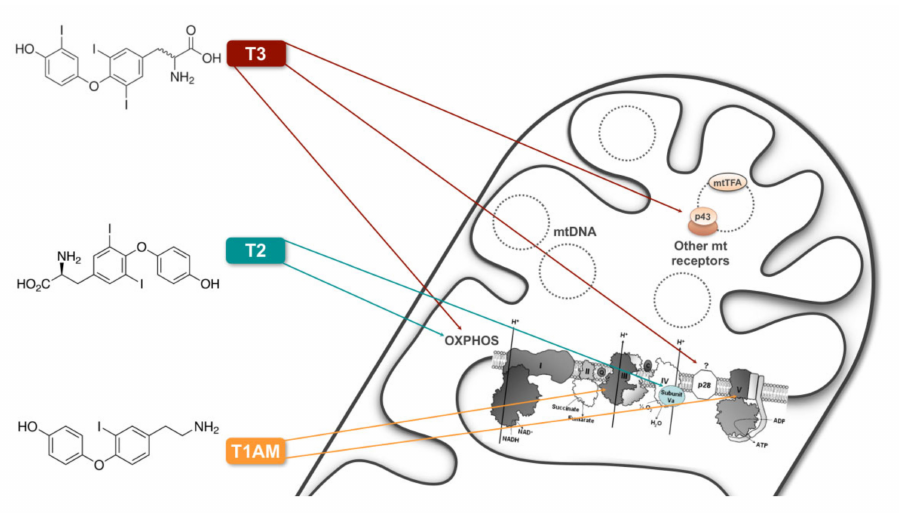
Figure 2. Nongenomic actions of T3 and its endogenous metabolites, T2 and T1AM, on mitochon- drial respiratory chain. Cross-section of a mitochondrion (mt), with a schematic view of OXPHOS. I = Complex I; II = Complex II; III = Complex III; IV = Complex IV; V = Complex V. Arrows indicate the so far identified molecular targets of the three molecules. T3, through p43, affects mitochondrial transcription and protein synthesis and the overall activity of the OXPHOS. T2, like T3, is able to modulate the OXPHOS and to directly stimulate Complex IV (COX) activity, likely specifically binding the Va subunit. T1AM was demonstrated to modulate Complex V kinetic properties and to partially block Complex III. Mitochondrial actions of T3 mediated by p28 largely remain unknown